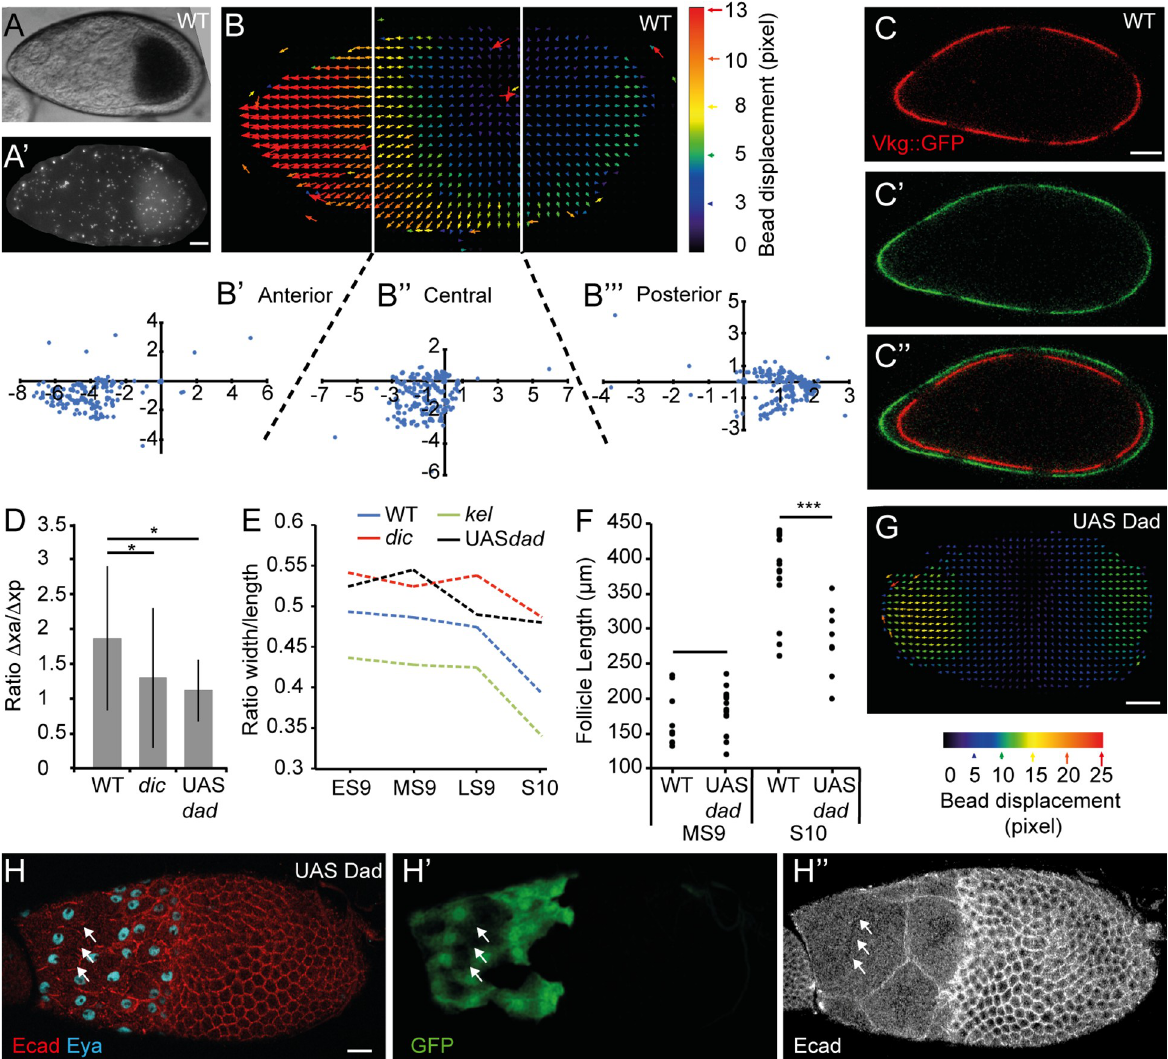
Fig 5. The follicles grow more anteriorly than posteriorly at S9. (A) A WT MS9 follicle covered with fluorescent beads (A’). Beads outside the follicle were manually removed to simplify the analysis. (B) Particle image velocimetry representation from the beads positioned on the follicle shown in (A) and plots presenting the coordinates of the vectors for the anterior (B’), central (B”), and posterior (B”‘) areas. For each area, the initial ( x , y ) coordinates of the beads are (0,0). Each blue dot corresponds to the final x and y coordinates of a bead in μ m. The vectors represent bead displacement (in pixel) and are color-coded as a function of their displacement. Duration of the experiment: 30 min. (C) WT MS9 follicle from a female carrying the vkg :: GFP transgene to mark the BM (red in C, green in C’). Six bleached areas are visible at t = 0 (C) and at t = 80 min (C’). The two images have been overlaid by aligning the central bleached areas (C”) to show follicle growth during the interval. (D) Box and whisker plot of the ratio between the anterior (“xa”) and posterior (“xp”) growths of the BM in WT ( n = 9), in dic follicles ( n = 6), and in Dad-expressing follicles ( n = 5). (E) Evolution of the ratio between the width and the length of the follicles from ES9 to S10 ( n > 20 per stage). (F) Comparison of follicle length at MS9 and at S10B between WT and Dad-expressing follicles ( n > 20 per stage). UAS- Dad is expressed under the tj -Gal4 driver. (G) Particle image velocimetry representation from the beads positioned on a Dad-expressing follicle. Duration of the experiment: 30 min. UAS- Dad is expressed under the tj -Gal4 driver. (H) MS9 Dad-expressing follicle. Only StC express Dad (GFP) (H’). The breakage of an NC membrane (arrows) are shown in H”. Scale bar: 20 μ m. Data for graphs (D), (E), and (F) can be found in the S1 Data file. BM, basement membrane; dic , dicephalic ; Ecad, Ecadherin; ES9, early S9; Eya, eye-absent expression; GFP, green fluorescent protein; kel , kelch ; LS9, late S9; MS9, mid S9; S, stage; StC, stretched cell; WT, wild